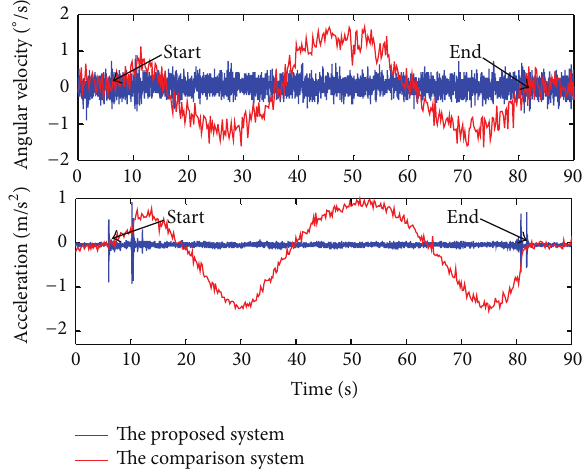
Figure 2: Outputs of 𝑥 -axis gyro and 𝑧 -axis accelerometer on a vibrating